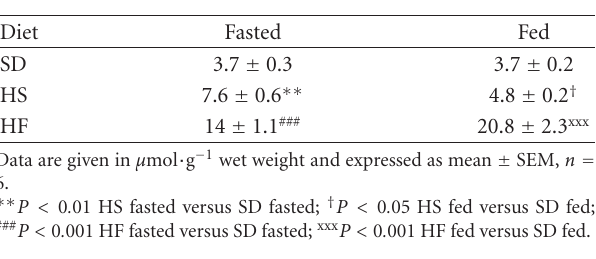
Table 2: Liver triacylglycerol